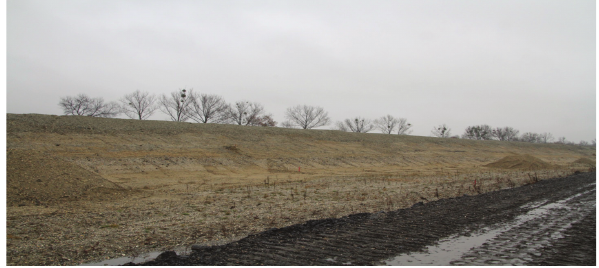
Figure 3: Fragment of the dam built of material from local mines, km